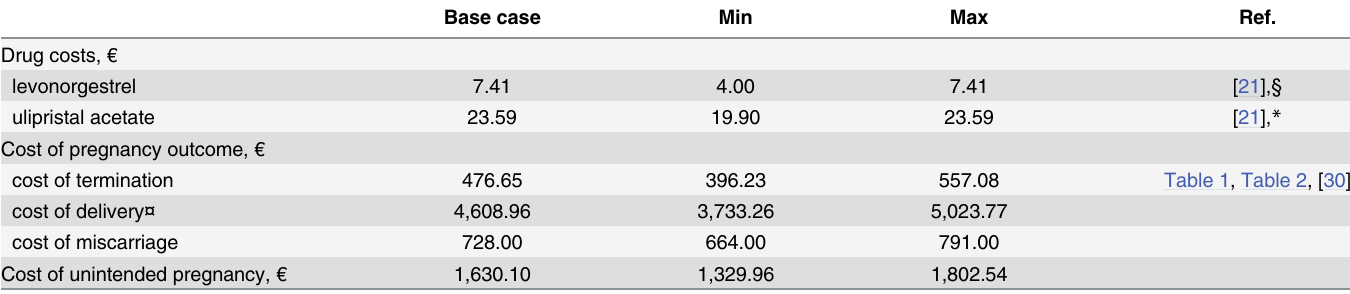
Table 3. Drug costs and cost of unintended pregnancy. Extreme values: ¤ hospital costs vary by +/-9% (29).; total costs of birth have been varied in the same range; § Norlevo (HRAPharma, France) and its generic price in case a generic drug will be launched;